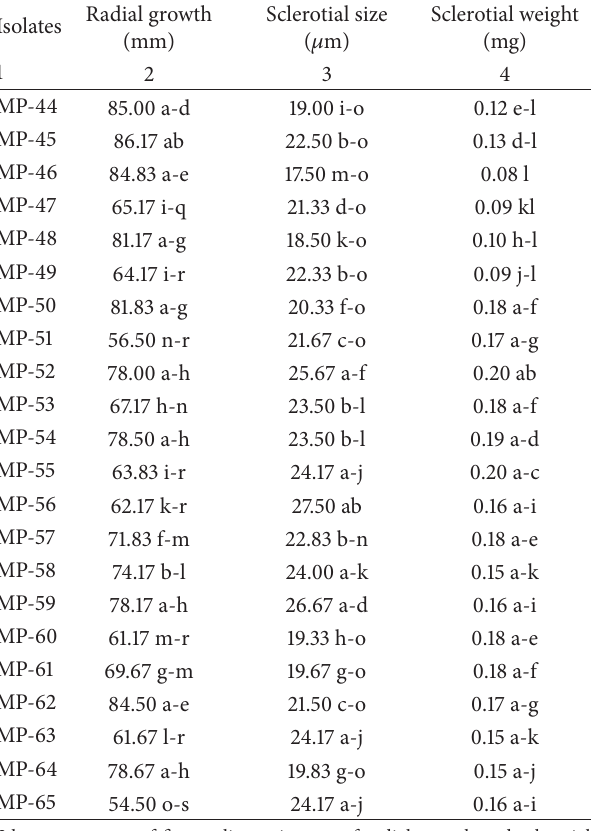
Table 2: Morphological variations among different isolates of M.